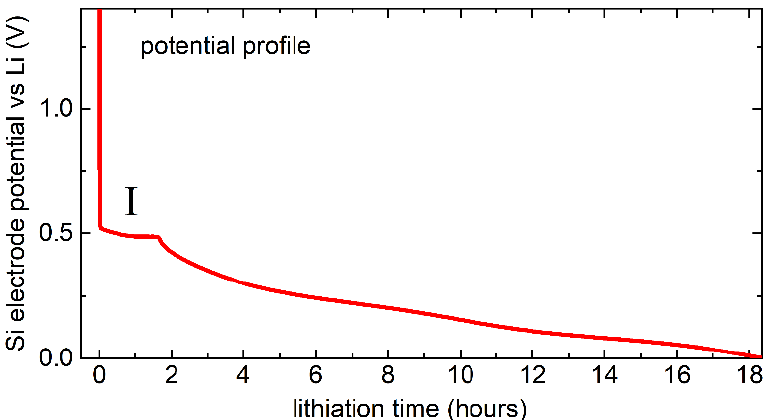
Figure 2. Variation in Si electrode potential with lithiation time during the first lithiation process of an a-Si thin film of 230 nm thickness at a constant current density of 11 µA/cm 2 . Unpublished ex- perimental data collected by the authors of the present work.